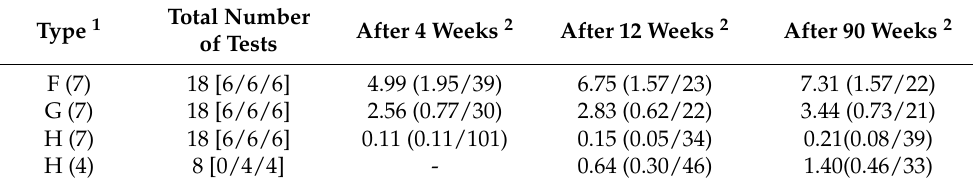
Table 6. Mortar TPT strength f m.TPT in MPa.